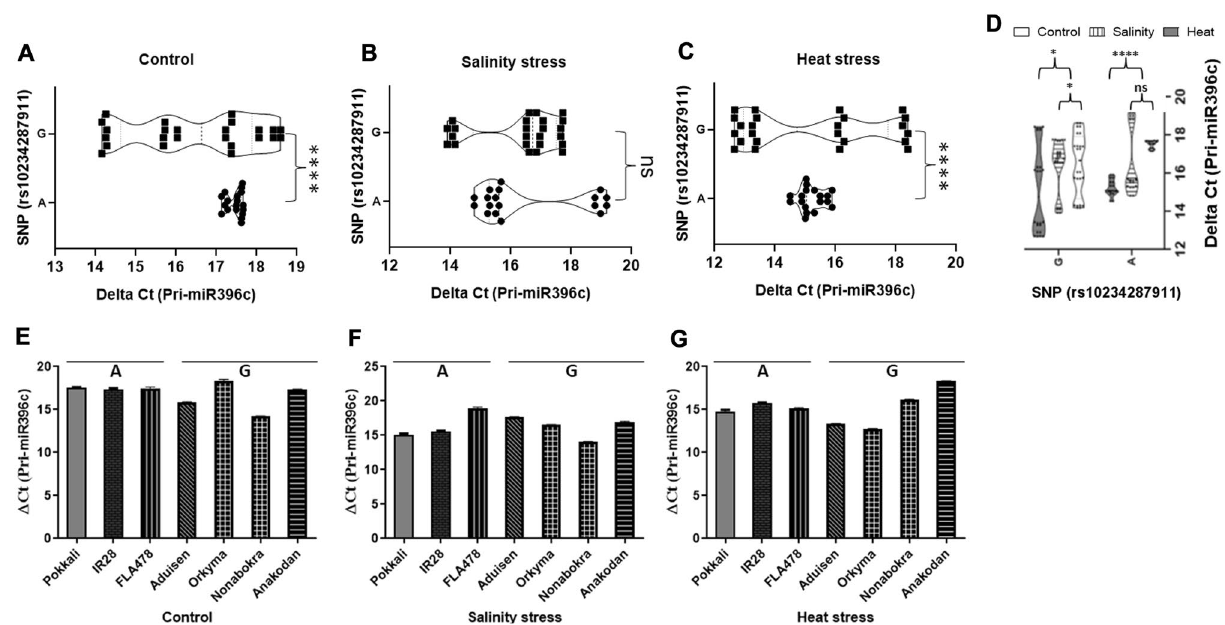
Figure 7. qRT-PCR analysis of pri- miR396c expression under control (untreated), salinity and heat treatments in rice landraces/varietiesgrouped either ‘A’ or ‘G’. Violin plots representing ΔC T values for pri- miR396c expression under control conditions in ( A ), salinity in ( B ) or heat stress in ( C ) for landraces/varieties grouped either as ‘A’ or ‘G. In ( E – G ), ΔC T values for pri- miR396c expression for individual landraces/varieties under the same conditions is shown. Pairwise statistical analysis of pri- miR396c expression in landraces grouped either ‘A’ or ‘G’ ( A – C ) or within landraces/varieties grouped ‘A’ or ‘G’ (control vs salinity or heat) using pairwise Student’s t-test (GraphPad V 6.0). Data is for three biological replicates per landrace/varieties per treatment (n = 3) with two/three technical internal replicates per treatment. ****: P < 0.0001, **; P < 0.05; ns: non